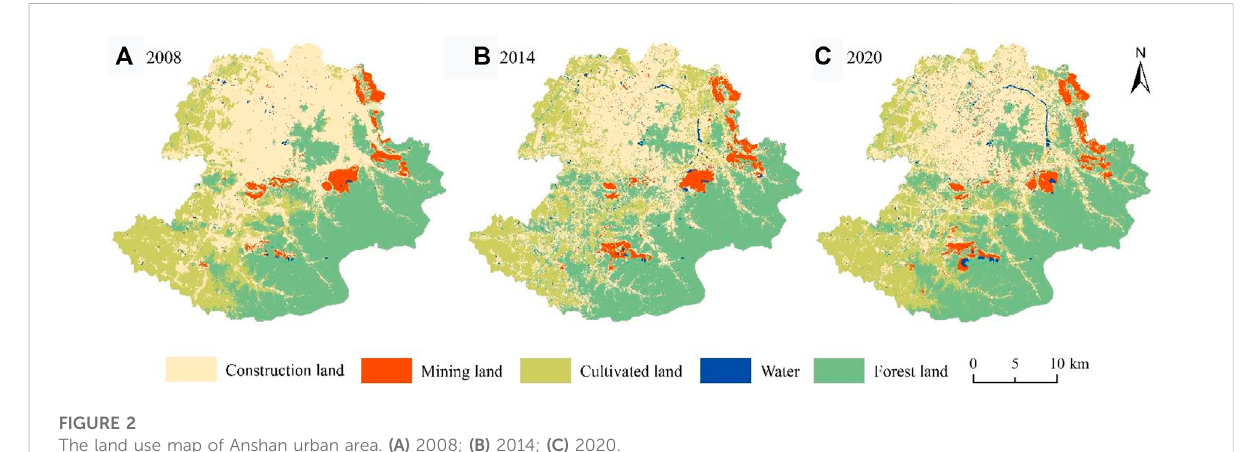
FIGURE 2 The land use map of Anshan urban area. (A) 2008; (B) 2014; (C)